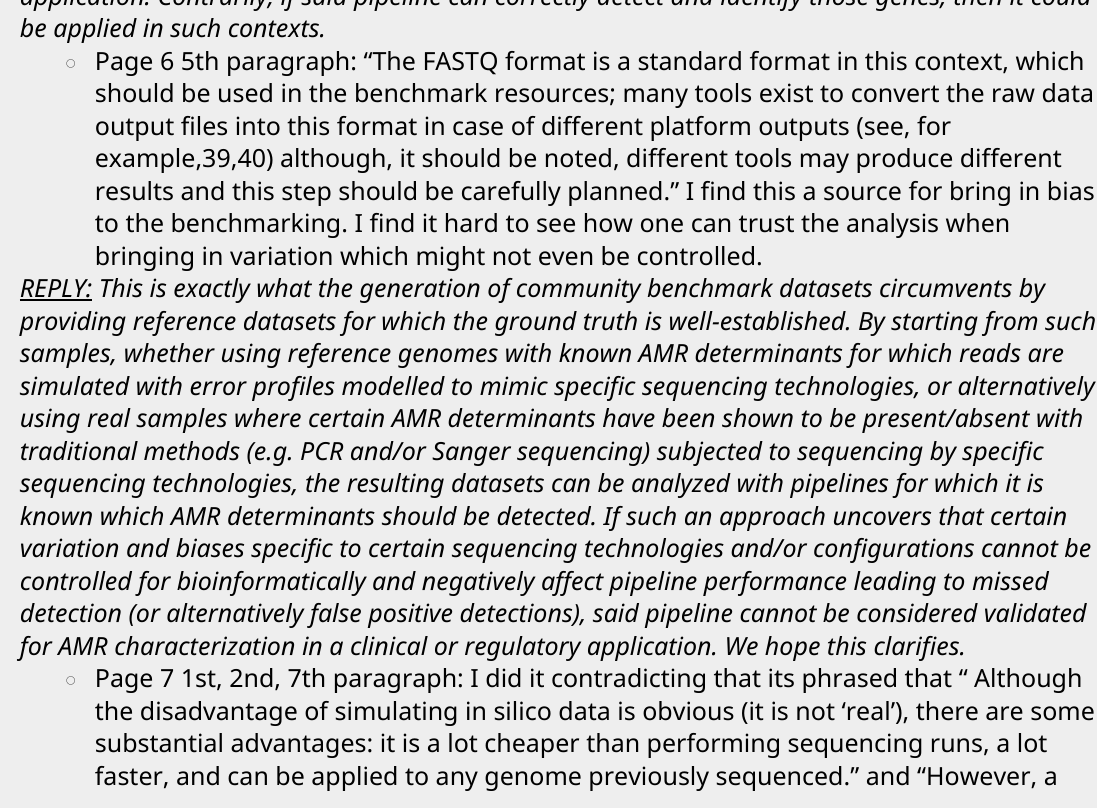
Fig 2: The data could easily be explained in text – omit fig 2 or reference already published similar